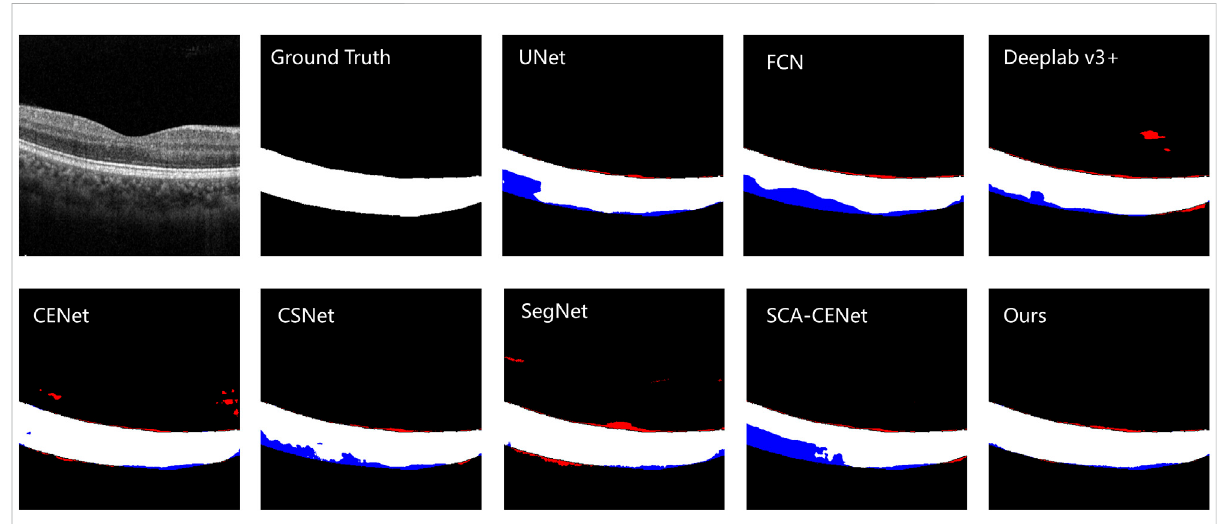
FIGURE 6 The visualization of the example result of choroid segmentation on the COSTA-H dataset. The fi rst image is the original image, the second image is the ground truth, and the next few images are the results of different methods of segmentation: the speci fi c methods are marked in the upper left corner of the image. White denotes a correctly segmented choroidal area, red denotes over-segmentation, and blue denotes under -segmentation.